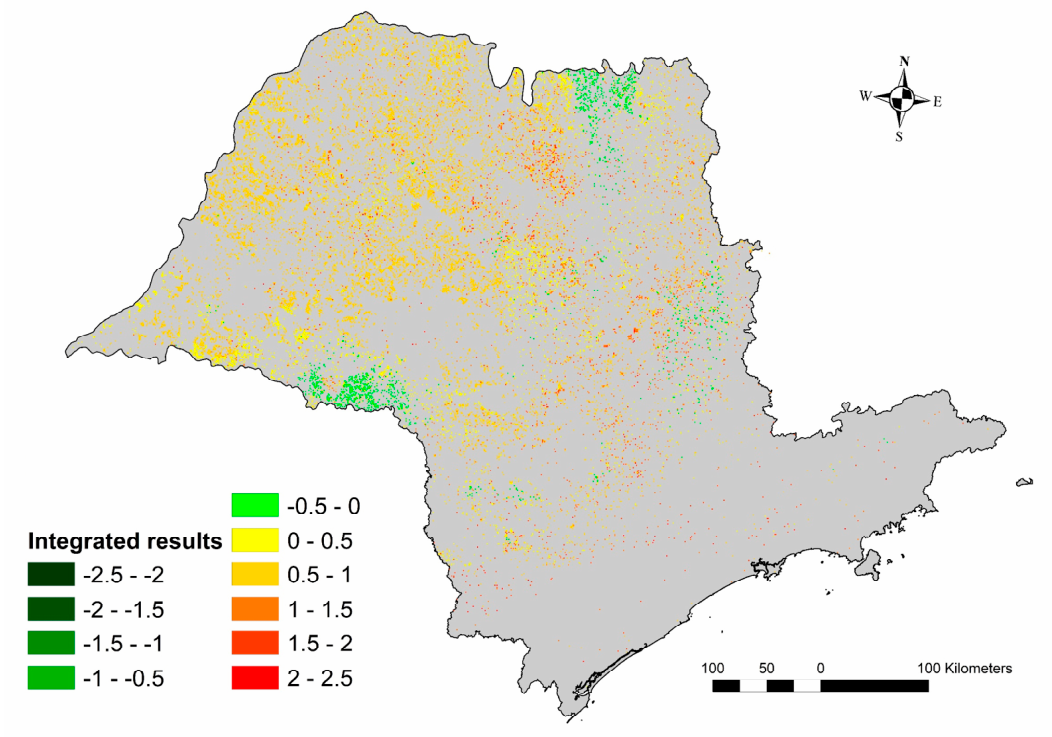
Figure 6. Environmental performance index from sugarcane expansion in the period of 2005 to 2015. Negative values indicate reduced environmental impacts of sugarcane compared to the previous land use /